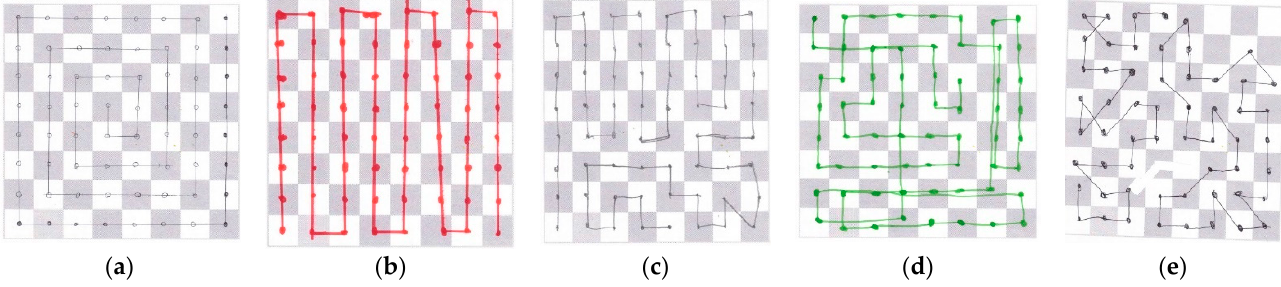
( e ) Figure 13. Chess routes with a knight. Drawing made by participant: ( a ) A5; ( b ) A7; ( c ) A3; ( d ) A4; ( e ) A6. In Figure 13, we can observe that the best performance is reached by participant A5. Repeating some patterns, A5 is able to pass through almost all squares. Participant A7 is also able to pass through all squares around a chosen one, but forgets to go through that one, although at the end gets a connected graph. A5 and A6 get a graph with two noncon- nected components, and A3 and A4 get more than two components. All of them except A6 follow some patterns and repeat them along the chessboard. A6 makes some mistakes joining the vertices, following a wrong knight movement.